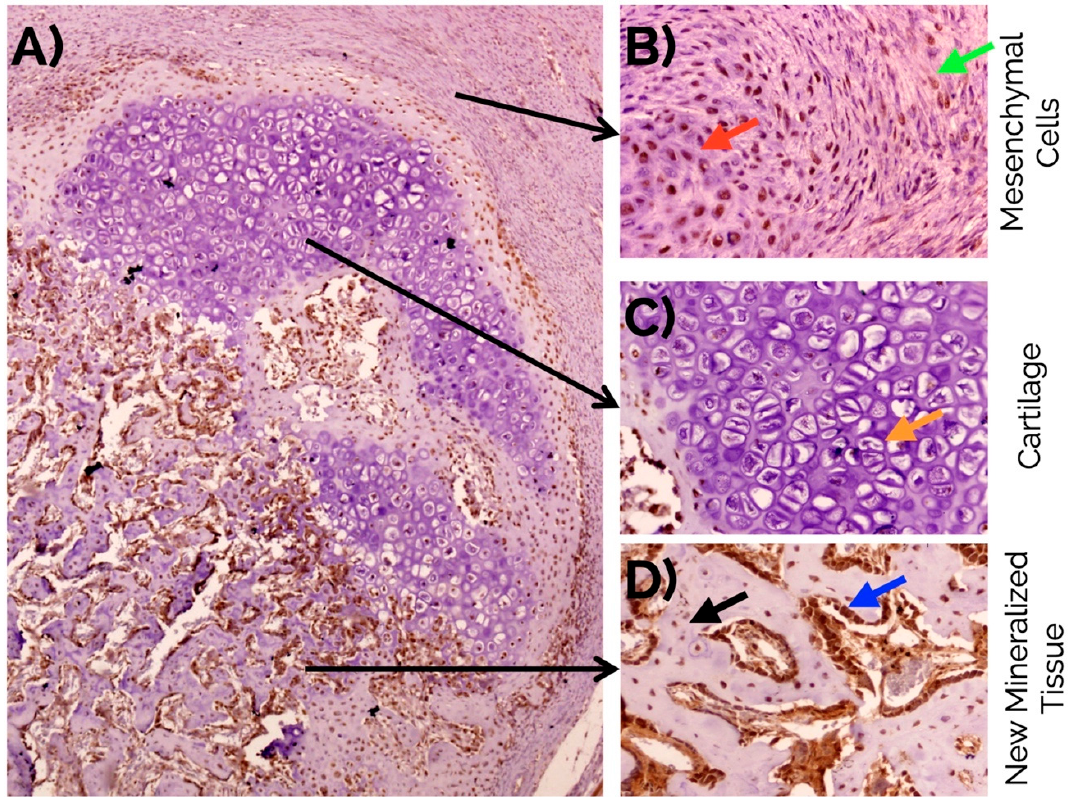
Figure 6. ( A ) Overview of RUNX2 detection in a bone fracture callus (in brown) and detail observations in ( B ) fusiform mesenchymal cells (green arrow), and immature chondrocytes (red arrow) in the fibrocartilage, ( C ) negative detection in mature hypertrophic chondrocytes (orange arrow), and ( D ) intense detection in the nucleus and cytoplasm of osteoblasts (blue arrow), and osteocytes (black arrow) in the newly formed bone. Peroxidase-conjugated micropolymer detection in samples from the 14-day time point. Original magnification: 10× ( A ) and 20× ( B – D ). This expression did not change notably over time except in MSC and immature chondrocytes. The expression of RUNX2 was statistically higher in osteoblasts, osteocytes